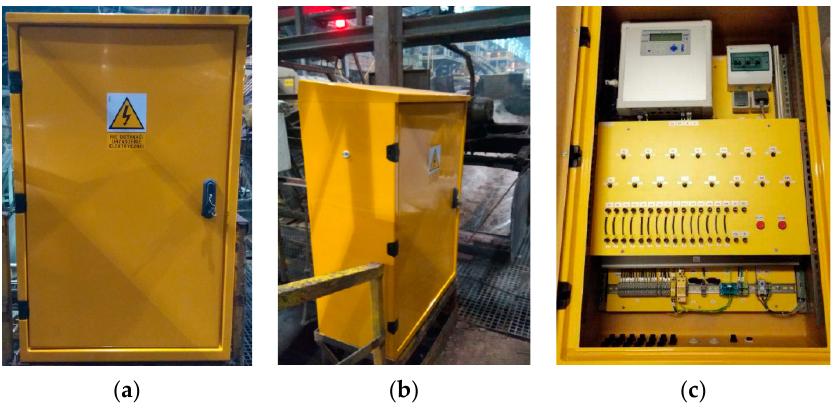
Figure 6. ( a ) Polarizer cabinet, ( b ) view of housing, ( c )